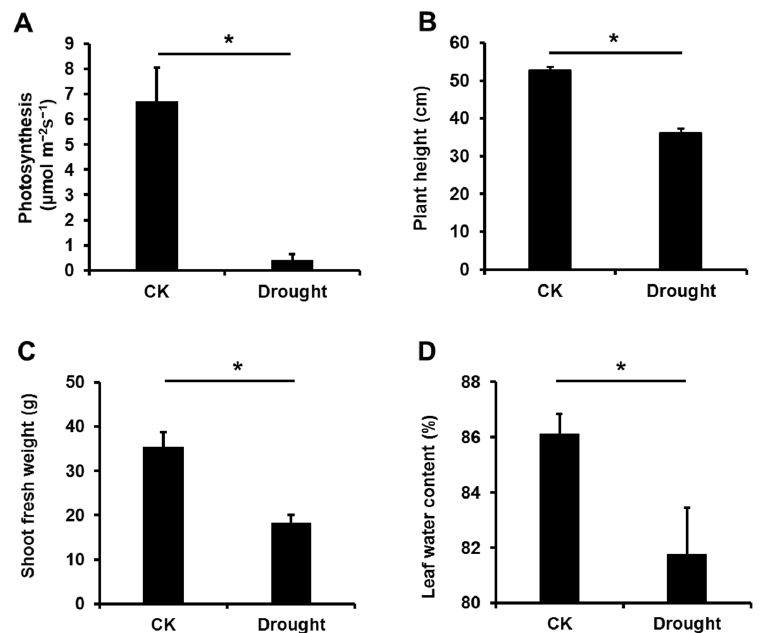
Figure 2. Physiological measurements performed using garlic plants at the end of drought treatment ( A ). Photosynthesis rate in leaves. ( B ). Plant height. ( C ). Shoot fresh weight. ( D ). Leaf water content. All measurements were obtained from at least three plants. Significance (*) was determined ( t -test); p < 0.05 indicated statistical significance.